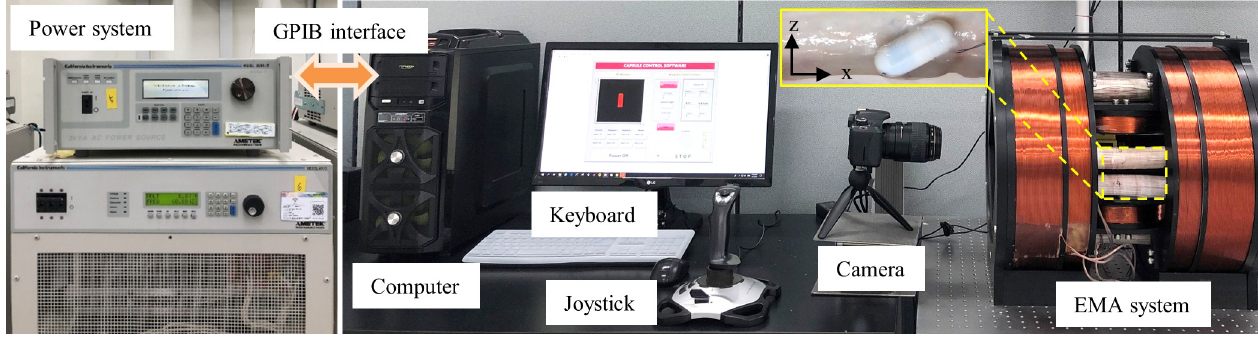
Fig 7. Real experiment setup for the in-vitro and ex-vivo tests.